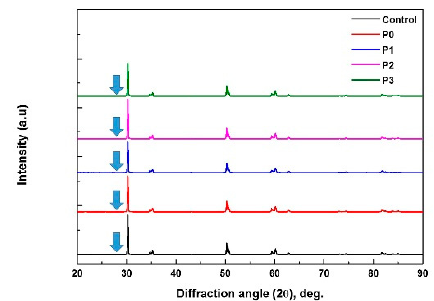
Figure 3. X-ray diffraction patterns of all zirconia groups after plasma treatment. Monoclinic phases were not seen in every experimental group (blue arrow).